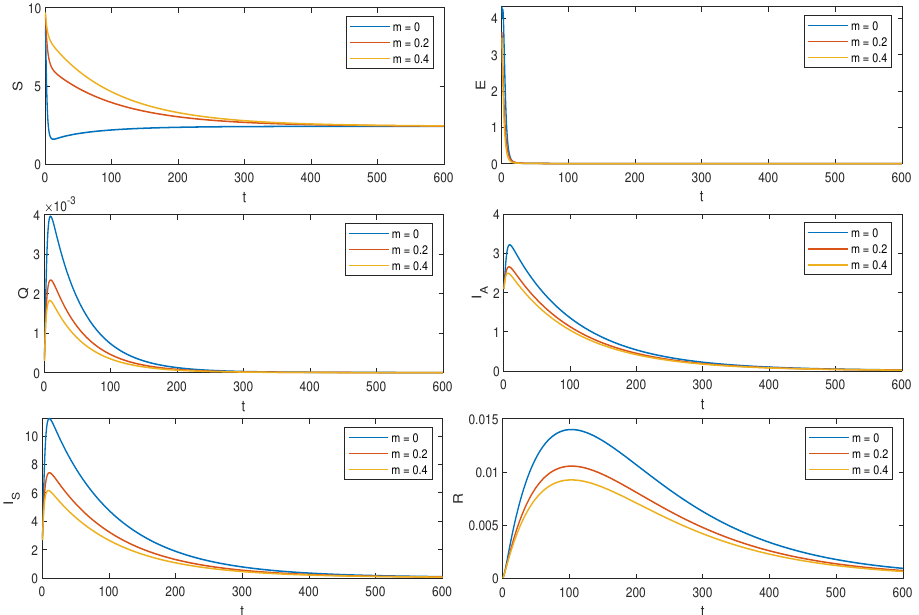
Figure 4. The effect of parameter m on the